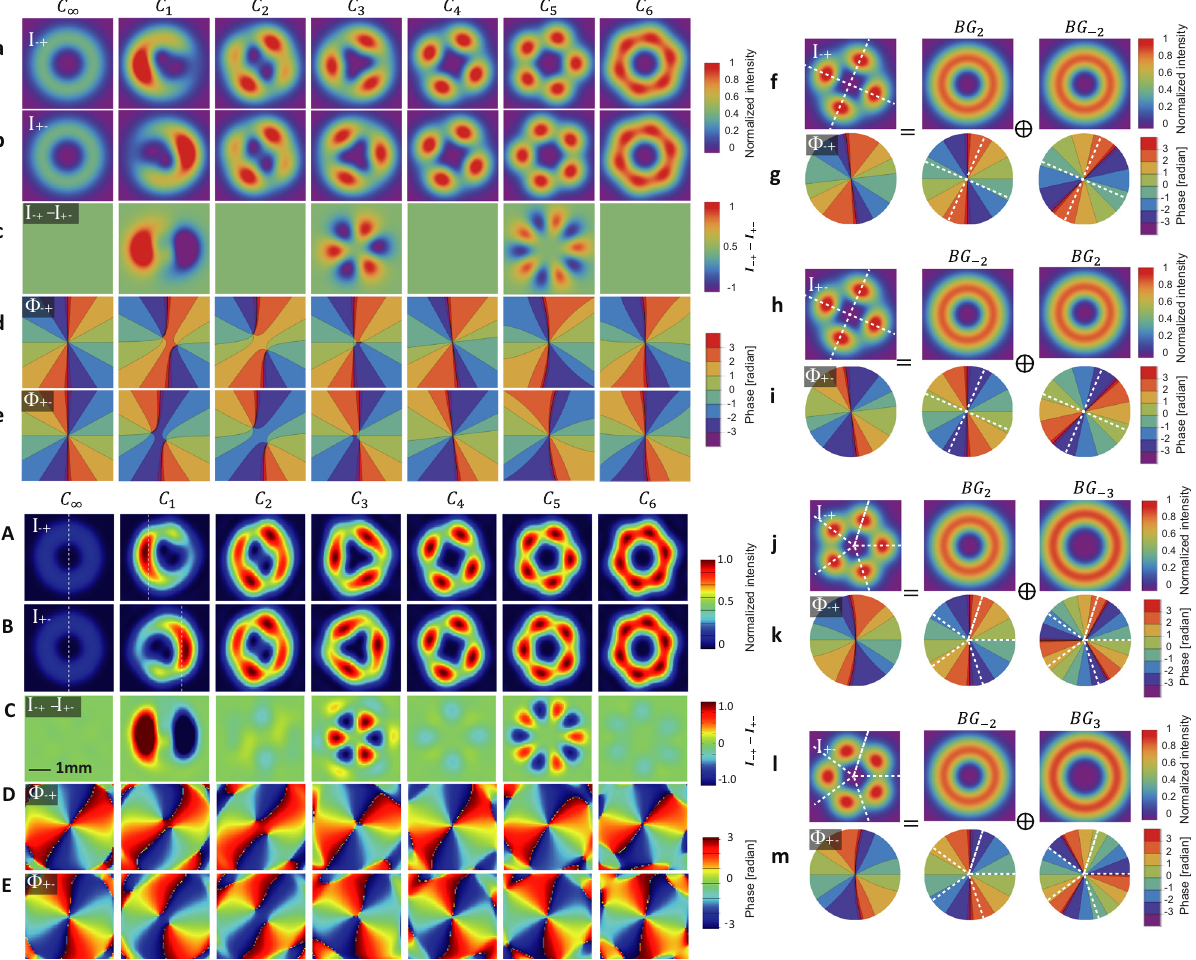
Figure 4: Analytical calculation and FDTD calculation of a spin-dependent beam separation for TA-CGSM. (a, b) Analytically calculated far-field intensity of I − + and I + − , respectively. (c)Calculated Δ I (cid:2) I − + − I + − . (d, e)Azimuthal distributionof phase for C ∞ h , C 1 h , C 2 h , C 3 h , C 4 h , C 5 h , and C 6 h TA-CGSM. (f-i) Partial-wave expansion of E − + and E + − of C 4 h CGSM. (A, B) FDTD calculated far- fi eld intensity of I − + and I + − , respectively. (C) Calculated Δ I (cid:2) I − + − I + − . (D, E) Azimuthal distribution of phase for C ∞ h , C 1 h , C 2 h , C 3 h , C 4 h , C 5 h , and C 6 h TA-CGSM. (j-m) Partial-wave expansion of E − + and E + − of C 5 h